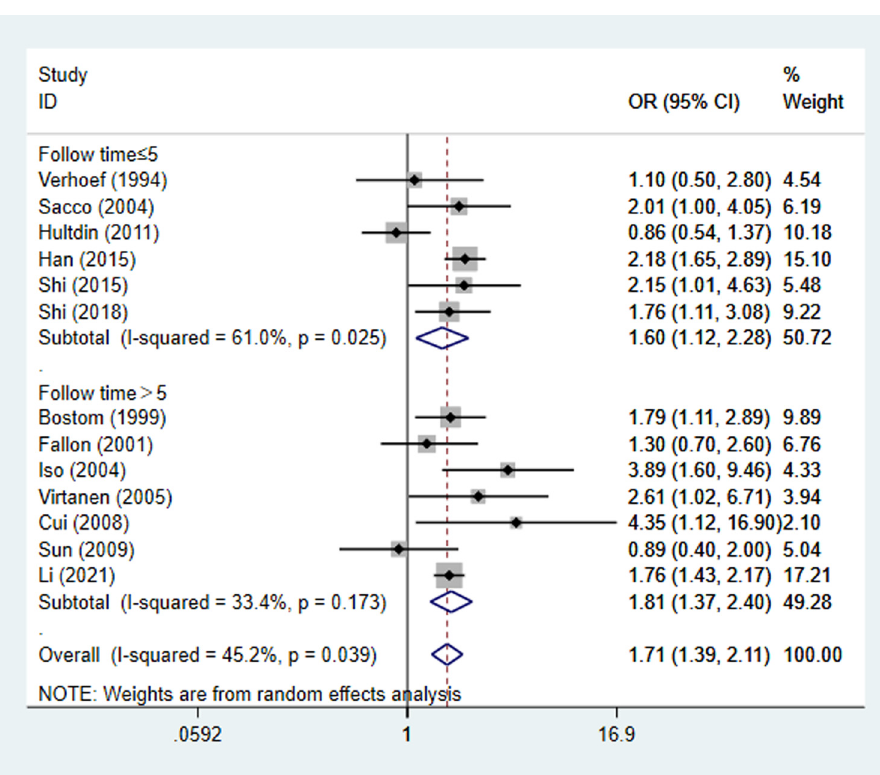
Figure 3: Forest plots showing the e ff ect of elevated Hcy levels on ischemic strokes. High Hcy levels increased the risk of ischemic strokes with adjusted OR of 1.71. Subgroup analysis based on follow - up length showed that high Hcy levels were associated with an increased risk of ischemic stroke regardless of follow - up